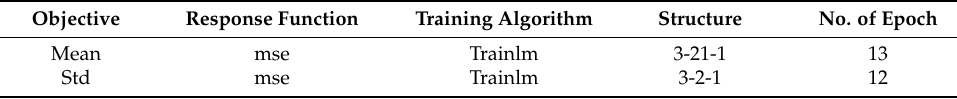
Table 2. Parameters of NN-based estimation method.